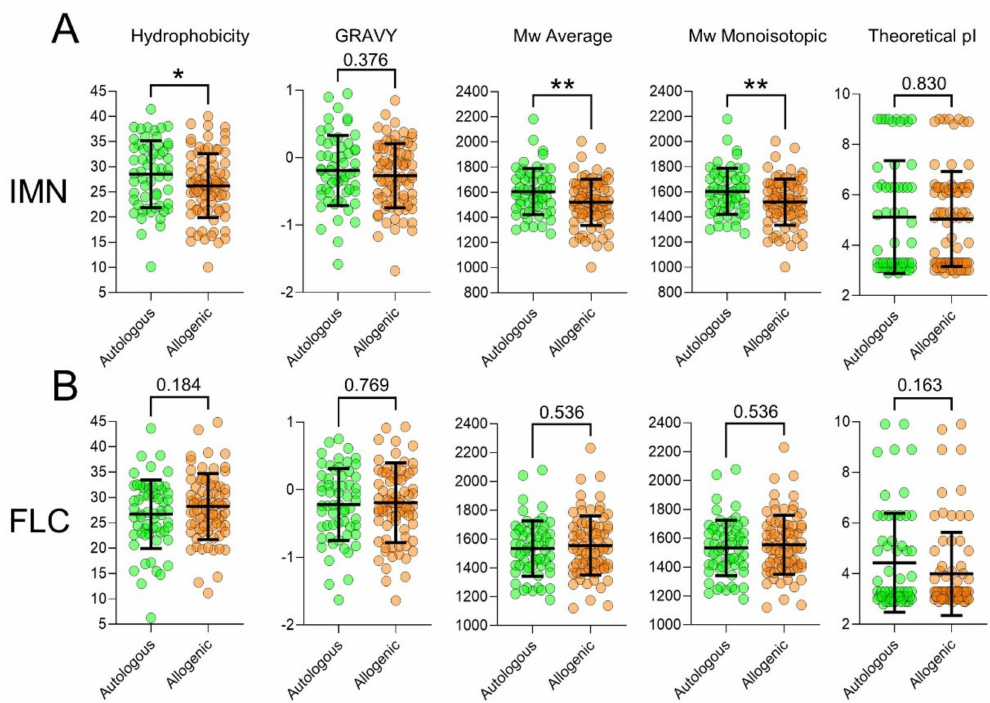
Figure 6. Physical-chemical properties analysis of CDR3 loops between auto-reactive and allo-reactive TCRs. ( A ) IMN CDR3 (green) and ( B ) FLC CDR3 loops (orange) were compared by hydrophobicity, GRAVY, Mw average, Mw monoisotopic and theoretical pI scores. TCR were pooled and measured by appearance. * p ≤ 0.05, ** p ≤